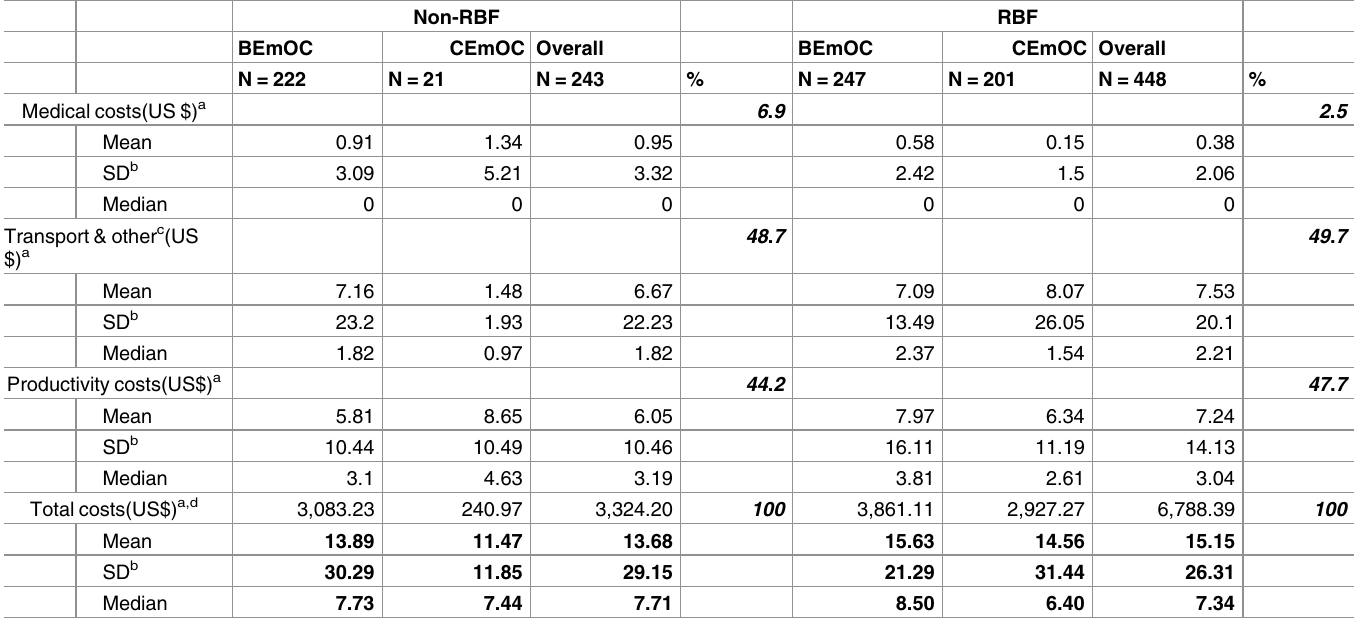
Table 4. Summaryof household costs for women admitted for complication care, by cost-categories and